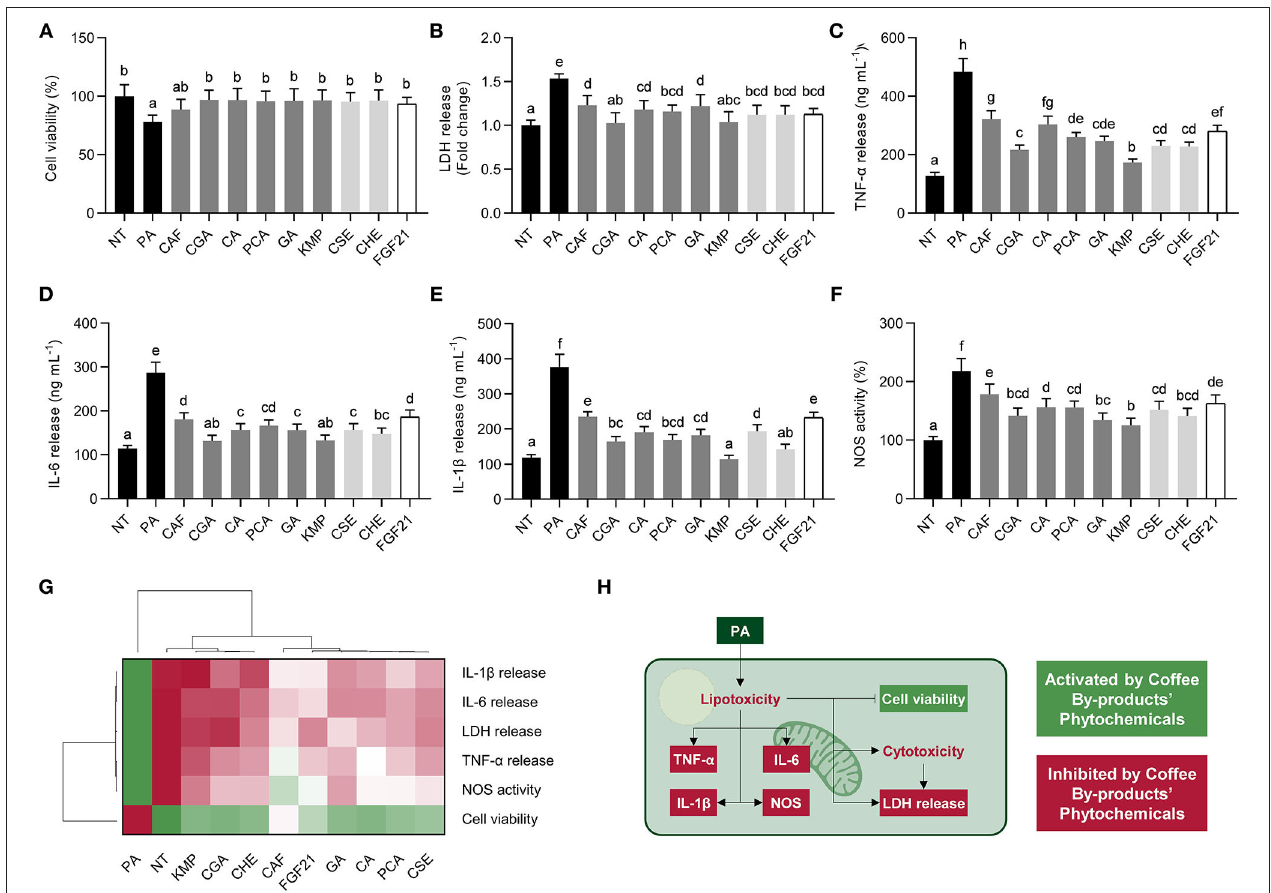
FIGURE 4 | Role of standard solutions of the bioactive compounds from coffee by-products (50 µ mol L − 1 ), aqueous extracts (CSE and CHE, 100 µ g mL − 1 ), and FGF21 (20 nmol L − 1 ), in the presence of palmitic acid (PA, 500 µ mol L − 1 ) on lipo/cytotoxicity and inflammation markers in HepG2 human hepatocytes. Coffee by-products’ bioactive compounds preserved cell viability (A) and diminished lactate dehydrogenase (LDH) release (B) . PA-triggered tumor necrosis factor α (TNF- α ) (C) , interleukin (IL)-6 (D) , and IL-1 β (E) release and nitric oxide synthase (NOS) activity (F) were reduced. Hierarchical cluster analysis and heat map [from the lowest ( (cid:4) red) to the highest ( (cid:4) green) value for each parameter] (G) and an integrative diagram illustrating the effects of the bioactive compounds from coffee by-products on lipo/cytotoxicity and inflammation (H) . The results are expressed as mean ± SD ( n = 3). Bars with different letters significantly ( p < 0.05) differ according to ANOVA and Tukey’s multiple range test. NT, non-treated cells; CAF, caffeine; CGA, chlorogenic acid; CA, caffeic acid; PCA, protocatechuic acid; GA, gallic acid; KMP, kaempferol; FGF21, fibroblast growth factor